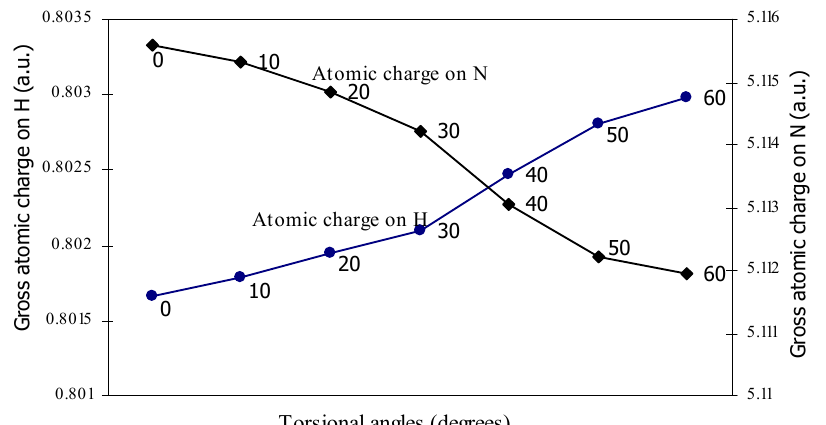
Figure 3. Plot of gross atomic charge densities on N and H atoms in F3B-NH3 system as a function of torsional